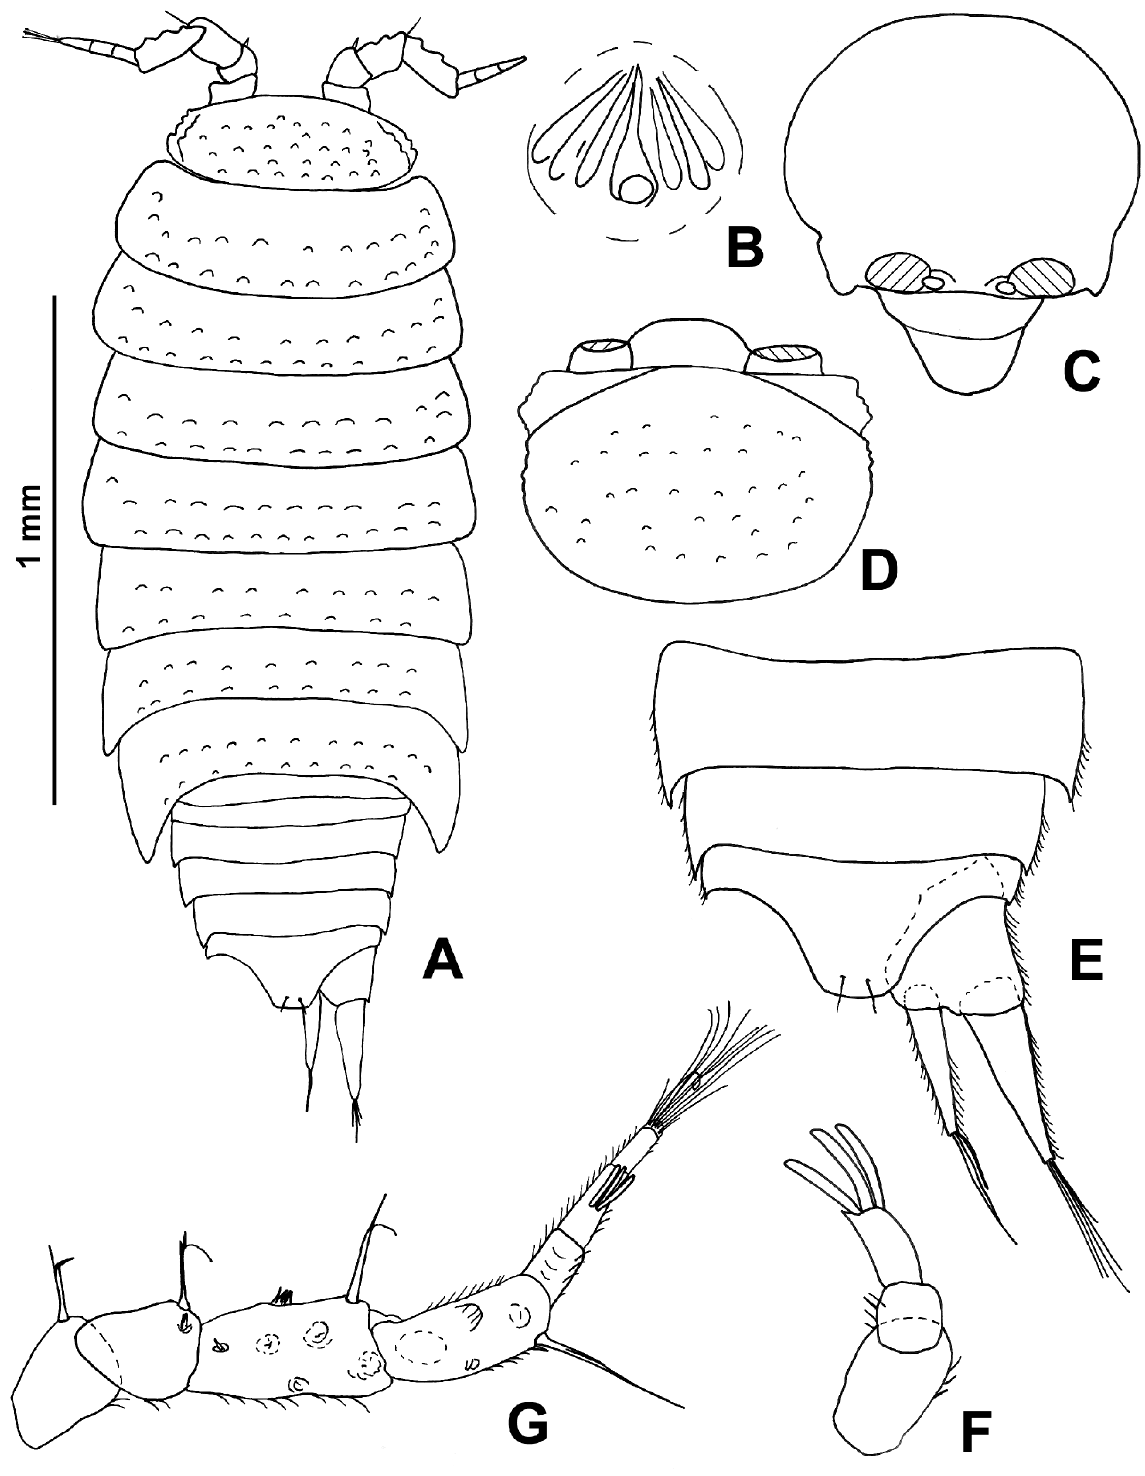
Fig. 4. Trichoniscoides bellesi Reboleira & Taiti sp. nov. from Algar do Javali, Montejunto. — Paratype, ♀. A . Adult specimen in dorsal view. B . Dorsal scale-seta. C . Cephalon in frontal view. D . Cephalon in dorsal view. — Paratype, ♂. E . Pleonites 4, 5, telson and right uropod. F . Antennula. G .